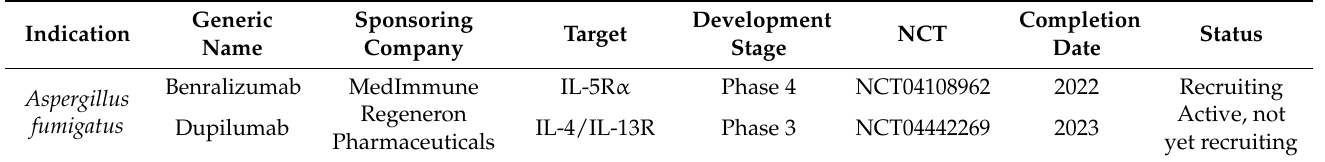
Table 5. Monoclonal antibodies for fungal respiratory